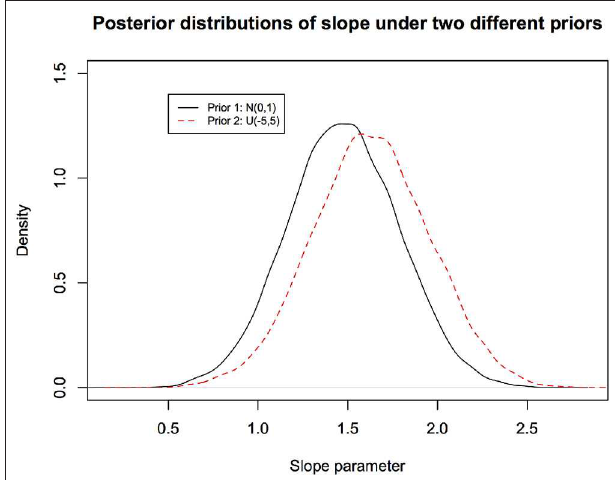
FIGURE 4 | Different prior distributions lead to different posterior distributions. They both cannot possibly have correct frequentist coverage. Their validity is epistemic and is not testable in any practical